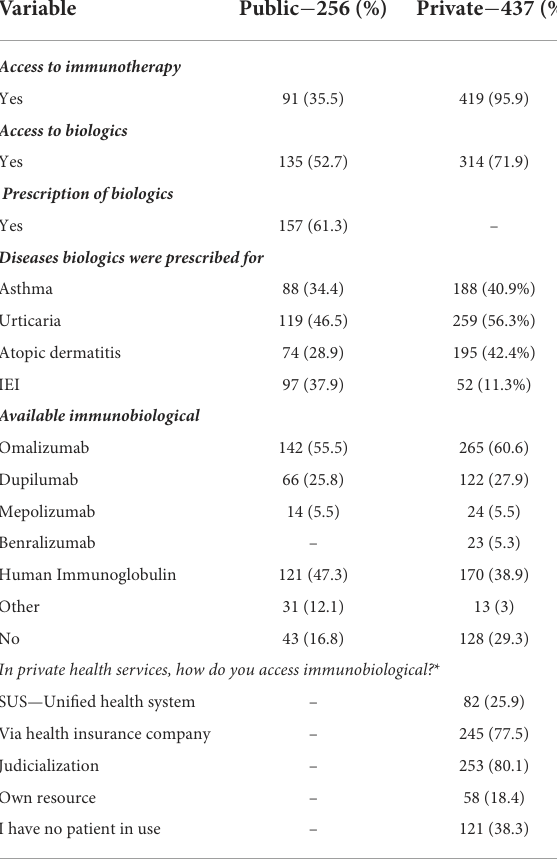
TABLE 3 Access to allergen-specific immunotherapy and biologics for patients in public and private health services, according to the specialists’ responses— n